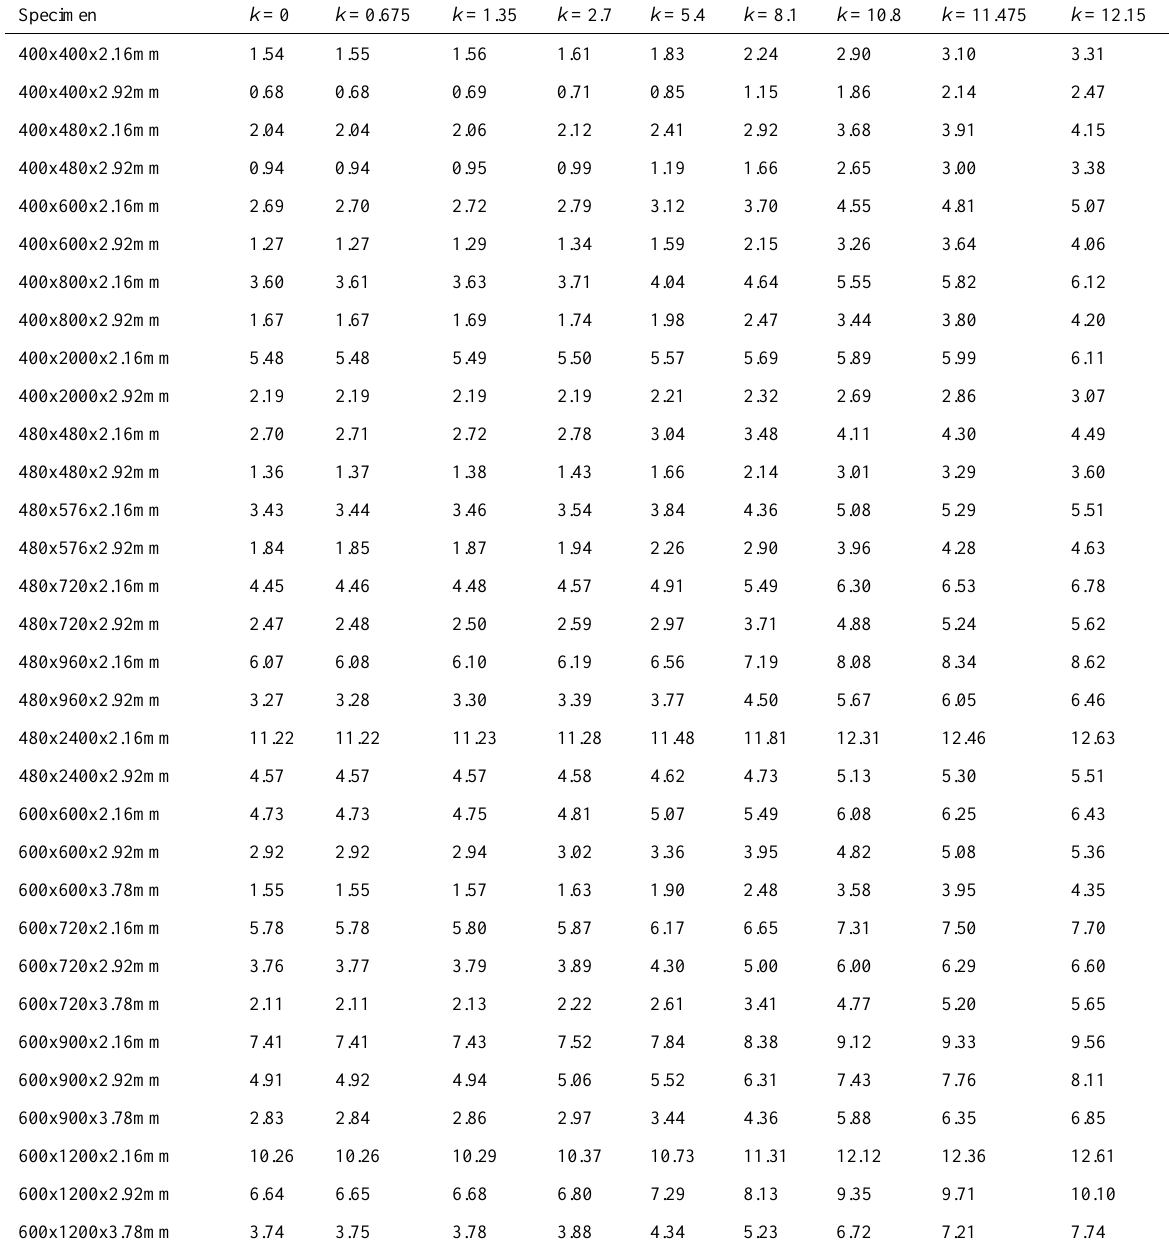
Table A1: Deflections at 1.0kPa transverse